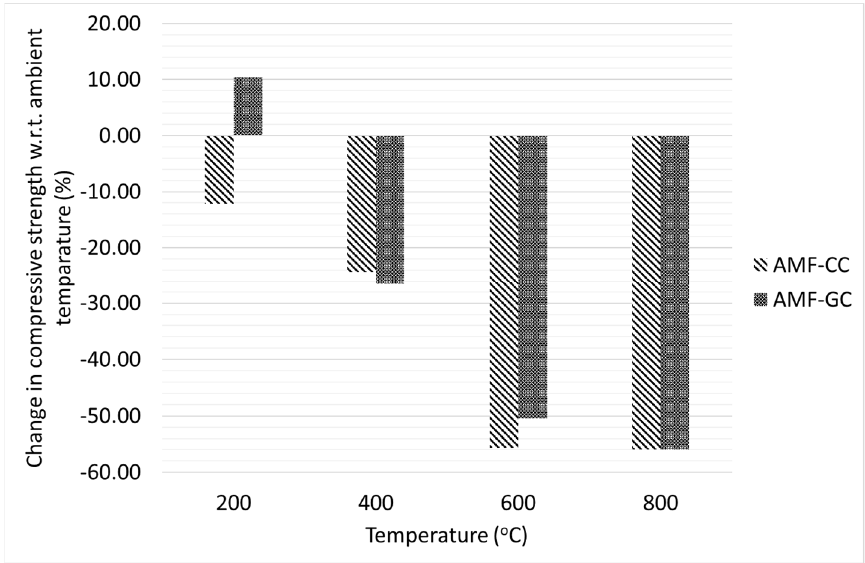
Figure 6. Change in compressive strength of AMF reinforced cement and geopolymer composite at elevated temperatures.